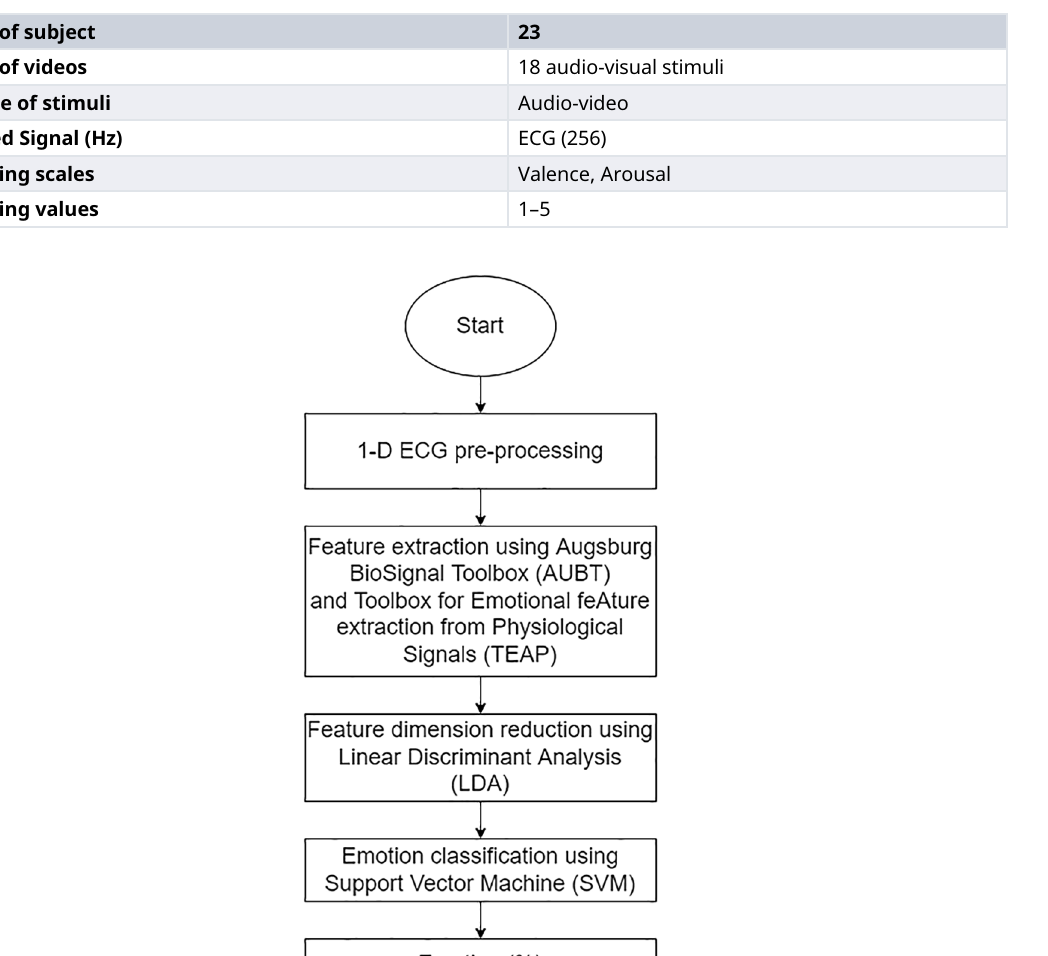
Table 2. The summary of the DREAMER dataset.